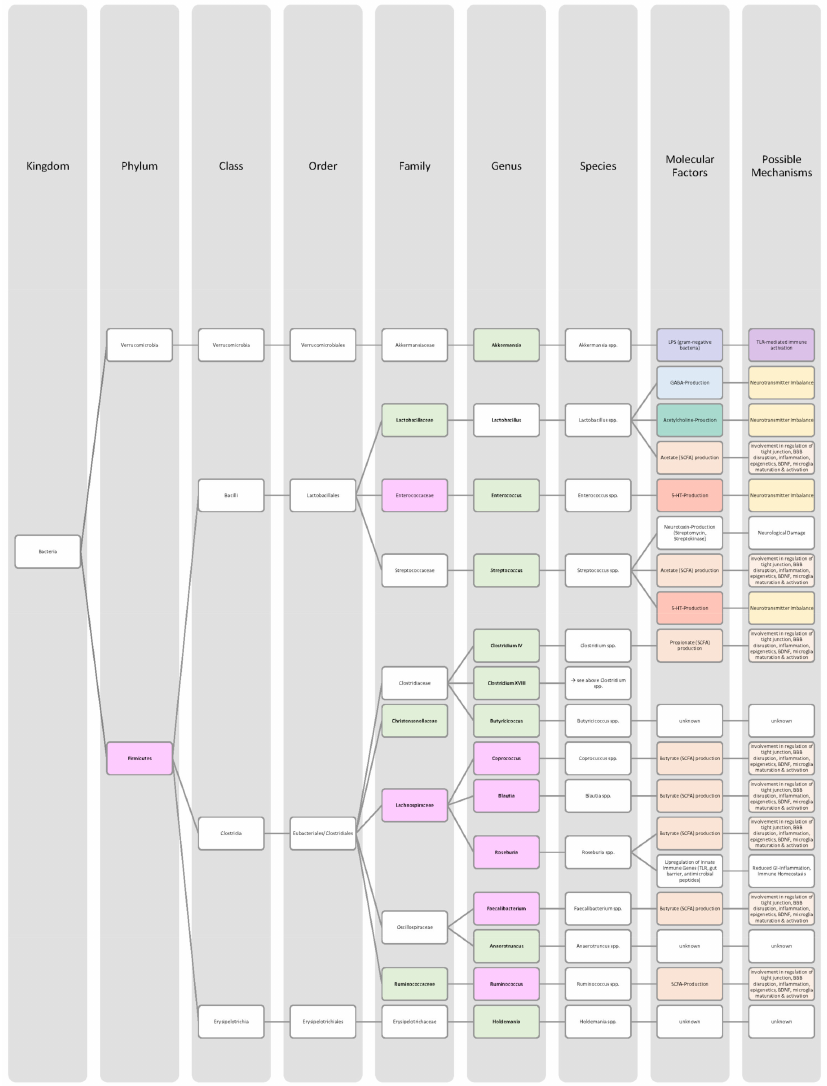
Figure 8. Part 1 of visual representation of the changes in microbiota composition in Parkinson’s disease patients from Table 6. For an explanation, see the legend of Part 2 in Figure